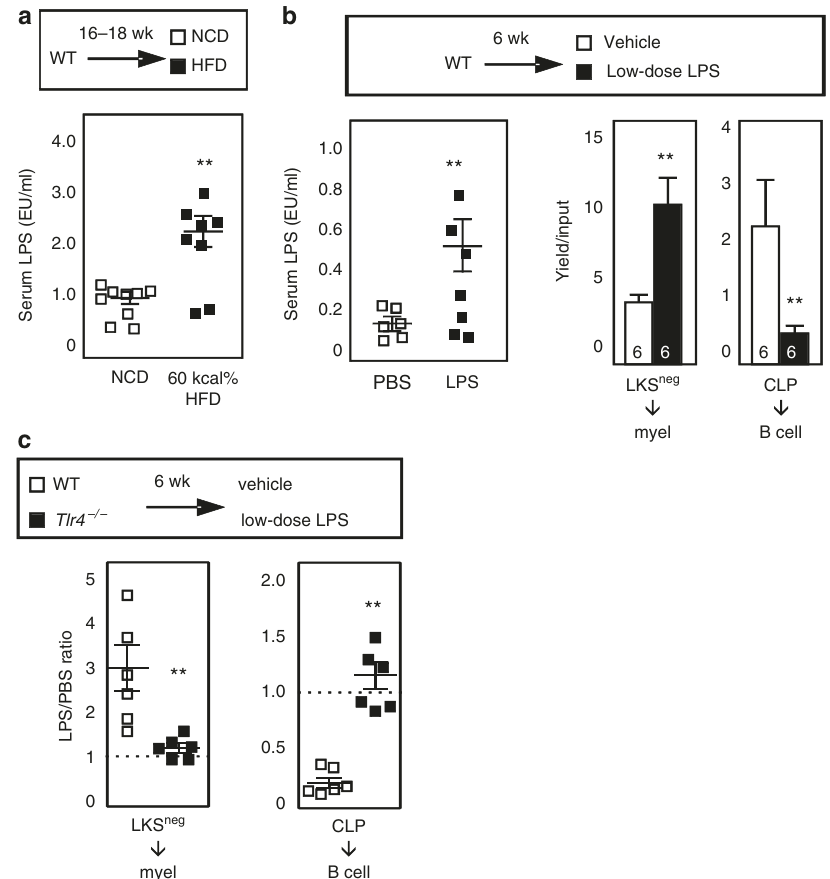
Fig. 4 Chronic low-dose LPS administered at levels found in obese mice induces myeloid bias. a Serum LPS levels in B6 mice fed the indicated high-fat or control diet for 16 – 18 weeks. Data are pooled from 3 independent experiments in which NCD/HFD mice were analyzed side-by-side (total n = 8 – 9 mice/ group). b , c WT or Tlr4 − / − mice were exposed to chronic low-dose LPS or PBS vehicle for 6 weeks after which serum LPS levels were assessed and the outgrowth potential of sorted LKS neg and CLP subsets examined. Data are pooled from two to three independent experiments in which PBS and LPS mice were examined in parallel. Bar graphs depict average ± SEM, with number of mice inset. For scatter plots, each symbol is an individual animal. Data are analyzed by Student ’ s t-test. Error bars represent s.e.m. ** p <